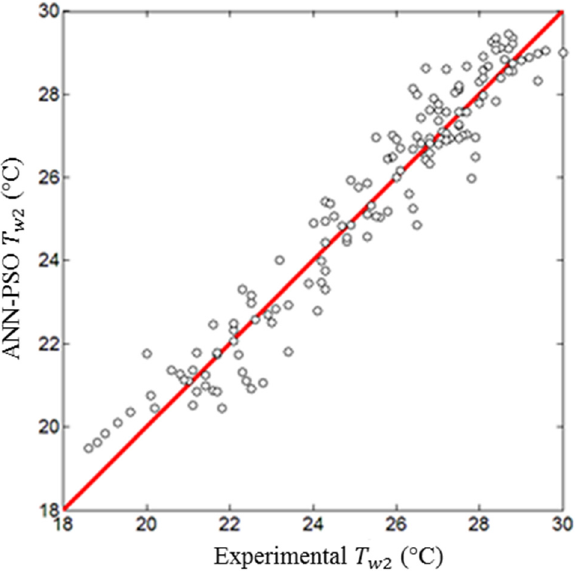
Figure 16. Estimated outlet water temperature by ANN ‐ PSO based on experimental data (training stage).